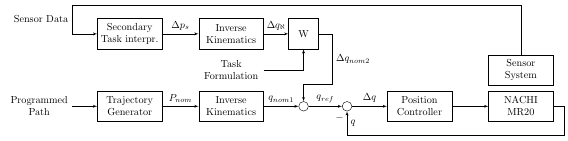
Figure 5: System structure with the secondary task in an external feedback loop.